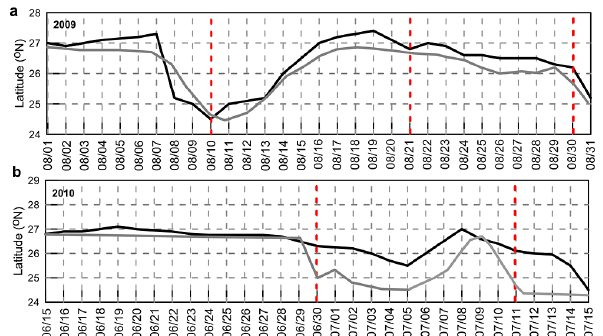
Figure 4. Latitude of furthest northward penetration of the LC, derived from the GoM-HYCOM 17cm Sea Surface Height con- tour (black line) and adapted from Fig. 4 of Hamilton et al. (2011, grey line) during (a) August 2009 (Eddy Ekman event) and (b) June–July 2010 (Eddy Franklin event). Eddy detachment dates are indicated with vertical dashed red